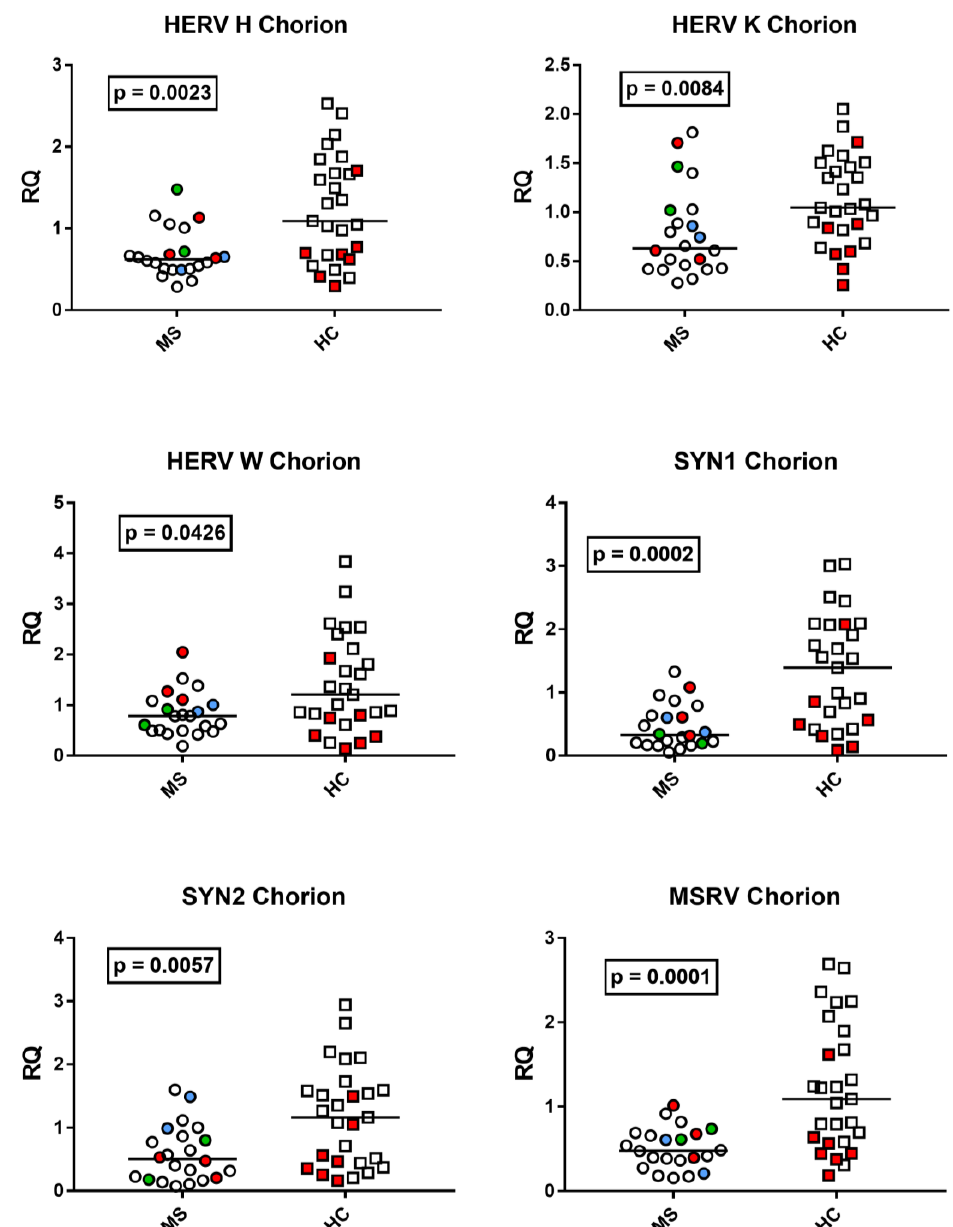
Figure 6. Expression of pol genes of HERV-H, -K, and -W and of env genes of Synctyn (SYN) 1, SYN2, and of multiple-sclerosis-associated retrovirus (MSRV) in the chorion of 22 placentas from 20 mothers with multiple sclerosis (MS) and 27 healthy control (HC) mothers. RQ: relative quantification. Circles and squares show the mean of three individual measurements; horizontal lines show the median values. Premature deliveries are shown in red; these include two pairs of twins in blue and